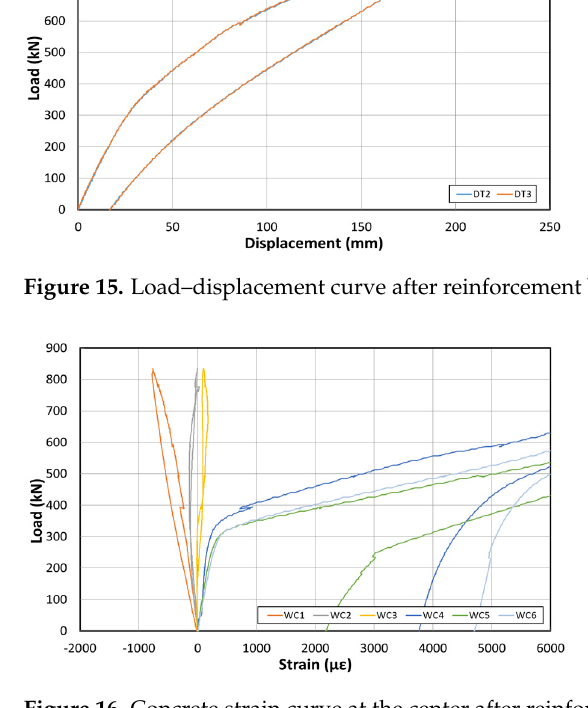
Figure 17. Inner tendon strain curve at the bottom after reinforcement based on the EP method. Figure 18 shows the crack map for loads up to the maximum load. Before reinforce- ment, cracks mainly occurred within the ±3 m interval from the girder center to both sides. After reinforcement, as the load increased, flexural tensile cracks tended to expand to val- ues within the ±6 m interval from the girder center on both sides. Figure 18. Crack map according to the load after reinforcement using the EP method.